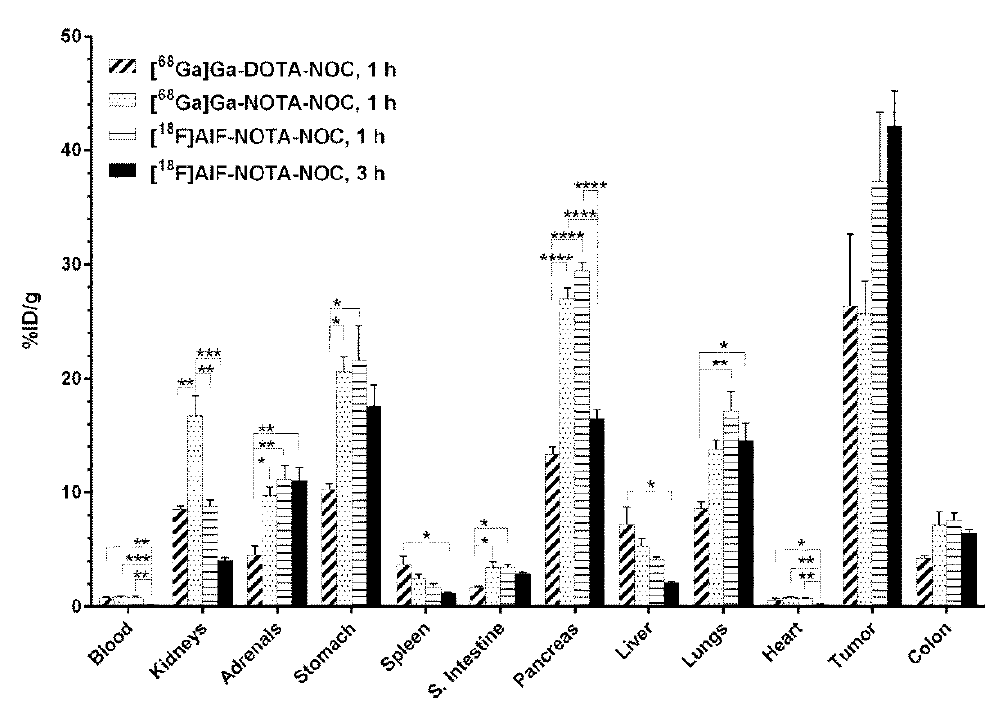
Figure 1. Biodistribution of [ 68 Ga]Ga-NOTA-NOC (50.2 ± 5 pmol, 627 ± 116 kBq), [ 68 Ga]Ga-DOTA- NOC (42.5 ± 6 pmol, 509 ± 24 kBq), and [ 18 F]AlF-NOTA-NOC (47 ± 10 pmol, 1017 ± 279 kBq) in AR42J xenograft mice. * p ≤ 0.05, ** p ≤ 0.01, *** p ≤ 0.001, and **** p ≤ 0.0001.